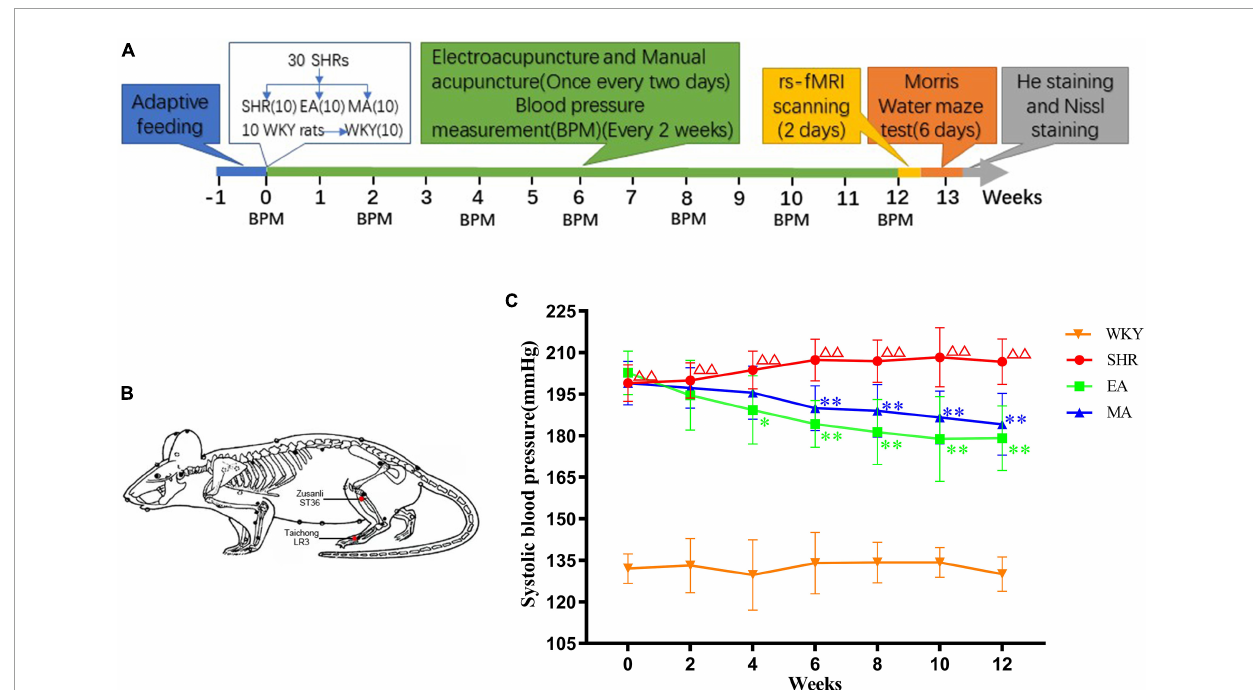
FIGURE1 Electroacupuncture and manual acupuncture attenuate hypertension in spontaneously hypertensive rats (SHRs). (A) Experimental procedures. (B) The location of acupoints in SHRs. Red dots indicate the location of Zusanli (ST36) and Taichong (LR3). (C) Systolic blood pressure values in each group. The values are presented as the mean ± SEM ( n = 10 rats/group). (cid:49)(cid:49) p < 0.01 vs. Wistar–Kyoto (WKY) group; ∗ p < 0.05 and ∗∗ p < 0.01 vs. SHR group. WKY, normal-control group; SHR, model group; EA, electroacupuncture-stimulation group; MA, manual acupuncture-stimulation